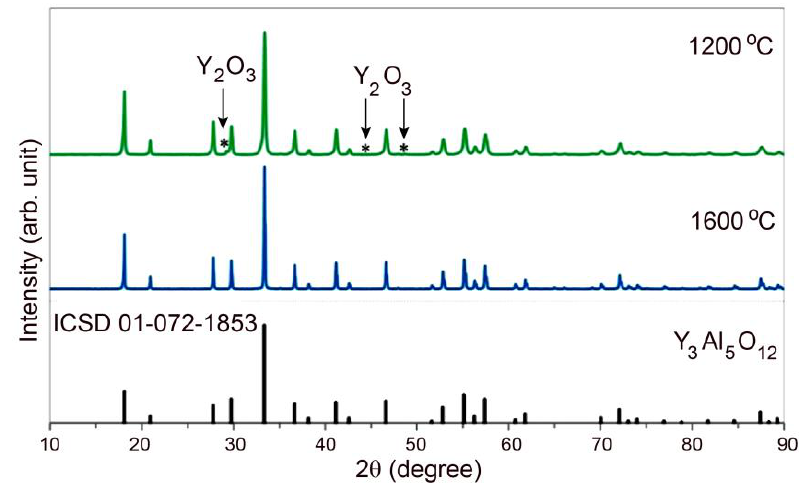
Figure 1. X-ray diffraction pattern of the ceramic powder being calcined at 1200 ◦ C and 1600 ◦ C in comparison with the XRD pattern of Y 3 Al 5 O 12 from the ICSD database (№ 01 -072-1853). Experimental data of refractive indices for three wavelengths (Table 2) were subse- quently fitted using a least-squares fitting program to the Sellmeier dispersion Equation (Figure 2):